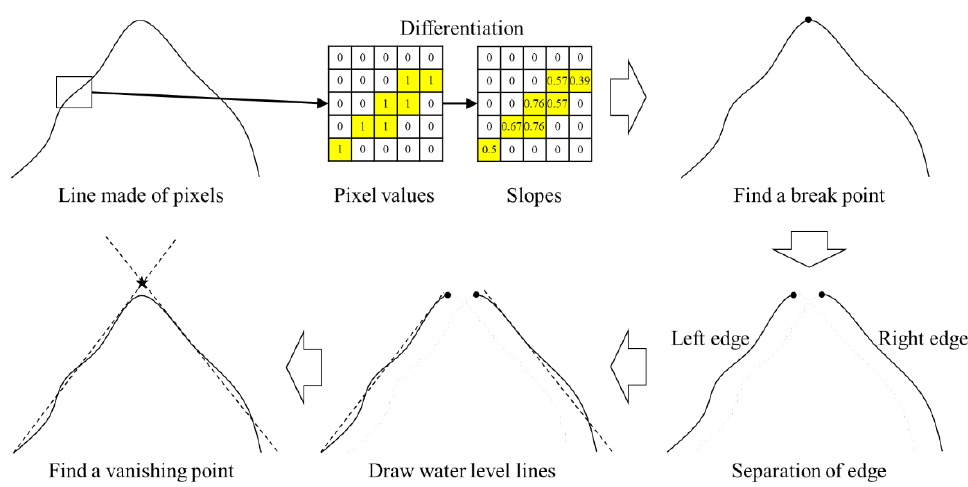
Figure 2. Extraction of linear water level lines from edge of water area.